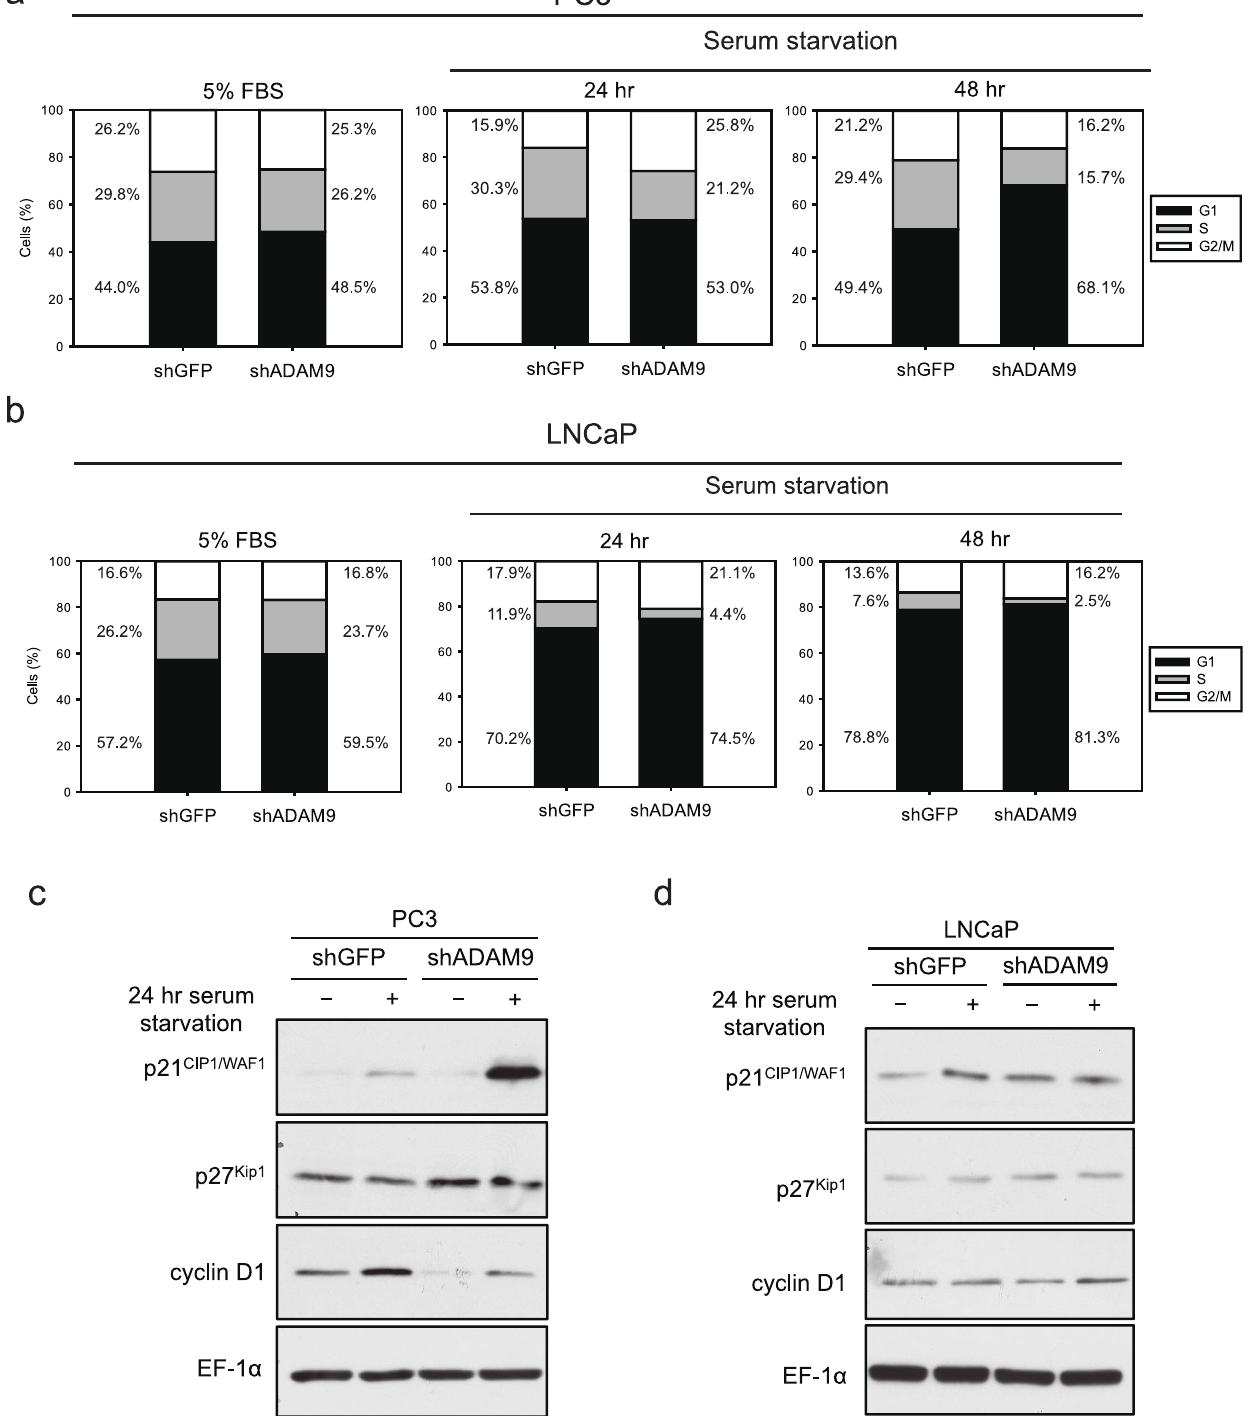
Figure 4. ADAM9 silencing induced G 1 arrest. Starvation reduced the S-phase cell population in ADAM9 knockdown cancer cells compared to that of controls in PC3 (a), LNCaP (b). (c) Expression levels of p21 Cip1/WAF1 , p27 Kip1 , and cyclin D1 increased in shADAM9 cells under starvation stress conditions in PC3 cells. (d) Expression levels of p21 Cip1/WAF1 and p27 Kip1 increased in LNCaP shADAM9 under both normal and starvation conditions. doi:10.1371/journal.pone.0053795.g004 either radiation therapy or chemotherapy agents, such as cancer cells correlates with cell survival during docetaxel therapy docetaxel, can enhance the level of ROS [31]. Maintaining [32]. Therefore, it is urgent to enhance therapeutic effects by lower concentration of endogenous ROS in docetaxel-resistant decreasing drug resistance of malignant cancer cells.